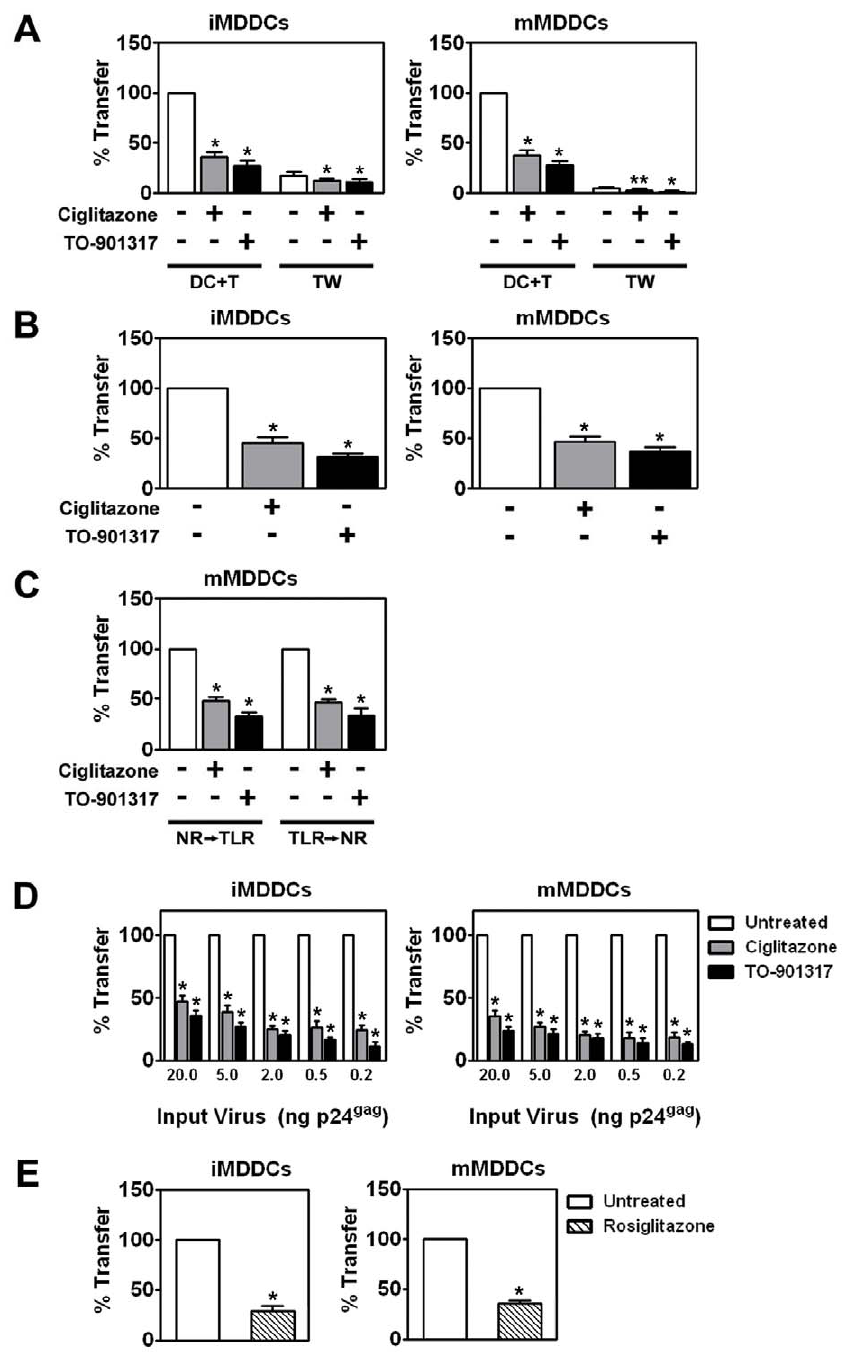
Figure 4. NR ligand treatment prevents HIV-1 trans -infection. (A) Immature (left panel) and LPS-matured (right panel) MDDCs were treated for 48 hours with 100 m M ciglitazone or 1 m M TO-901317 (NR ligands were added one hour prior to TLR ligand addition), incubated with replication competent HIV-1 ADA , washed, and cultured directly with autologous T cells (DC + T) or separated from the T cells by a Transwell insert (TW) for a period of 48 hours. Virus transfer and replication was measured by p24 gag ELISA. DC + T, MDDCs cultured directly with T cells. TW, MDDCs separated from T cells by a Transwell insert. Mean transfer/replication values: 9.18 ng p24 gag for untreated iMDDCs cultured directly with T cells; and 85.5 ng p24 gag for untreated mMDDCs cultured directly with T cells. (n=5) * (B) Immature (left panel) and PAM3CSK4-matured (right panel) MDDCs were treated for 48 hours with 100 m M ciglitazone or 1 m M TO-901317, washed extensively, and then incubated with HIV-1 ADA . After four hours, unbound virus was removed by extensive washing and the MDDCs were incubated directly with autologous primary T for 48 hours. The cells were then harvested, lysed, and assayed for virus transfer by p24 gag ELISA. (n=3) (C) MDDCs were treated with LPS and either 100 m M ciglitazone or 1 m M TO- 901317 for 48 hours (NR R TLR) or with LPS for 48 hours prior to treatment with NR ligands for an additional 48 hours (TLR R NR). MDDCs were incubated with HIV-1 ADA , washed, and cultured directly with autologous T cells. Virus transfer was measured by p24 gag ELISA. (n=3) (D) Immature (left panel) and LPS-matured (right panel) MDDCs were treated for 48 hours with 100 m M ciglitazone or 1 m M TO-901317 and incubated with increasing amounts of HIV-1 ADA , washed extensively, and then cultured with autologous T cells. Virus transfer was measured by p24 gag ELISA. (n=3)